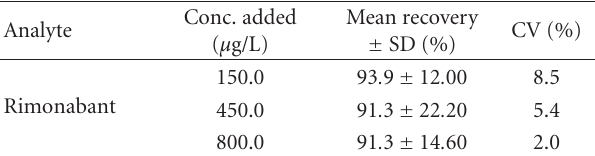
Table 2: Extraction recovery of rimonabant from plasma ( n =